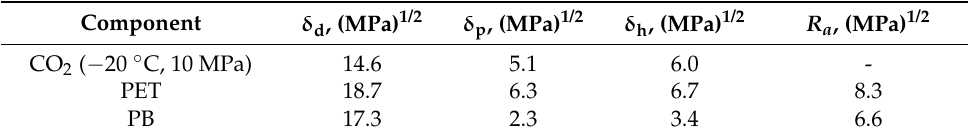
Table 2. The Hansen solubility parameters (HSPs) of CO 2 and polymers and the Hansen distance from CO 2